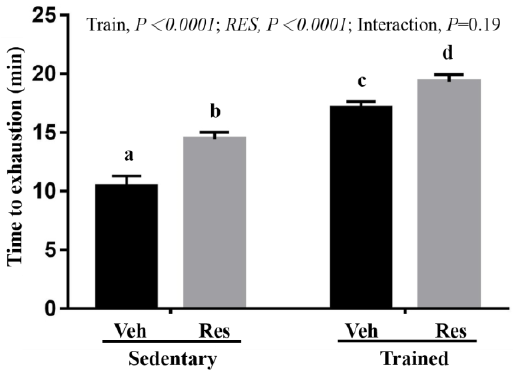
Figure 5. Effect of climb training (Trained) and/or resveratrol (RES) supplementation on aerobic endurance performance. Data are mean ± SEM for n = 10 mice per group and the columns with different superscript letters (a, b, c, d) are significantly different at P < 0.05. The abbreviations Veh and RES represented the vehicle and resveratrol supplement, respectively.